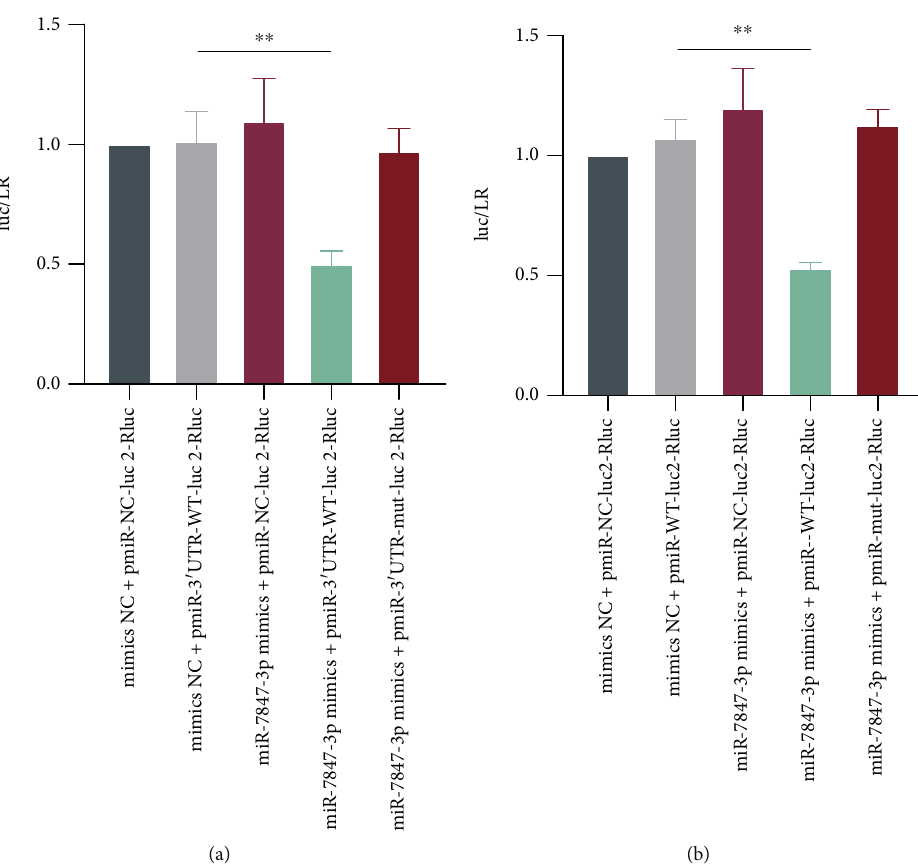
Figure 9: Dual-luciferase reporter gene detection of the binding sites between IL-17RA-1, miR-7847-3p, and PRKCG. (a) Binding sites detection between miR-7847-3p and PRKCG. (b) Binding sites detection between IL-17RA-1 and